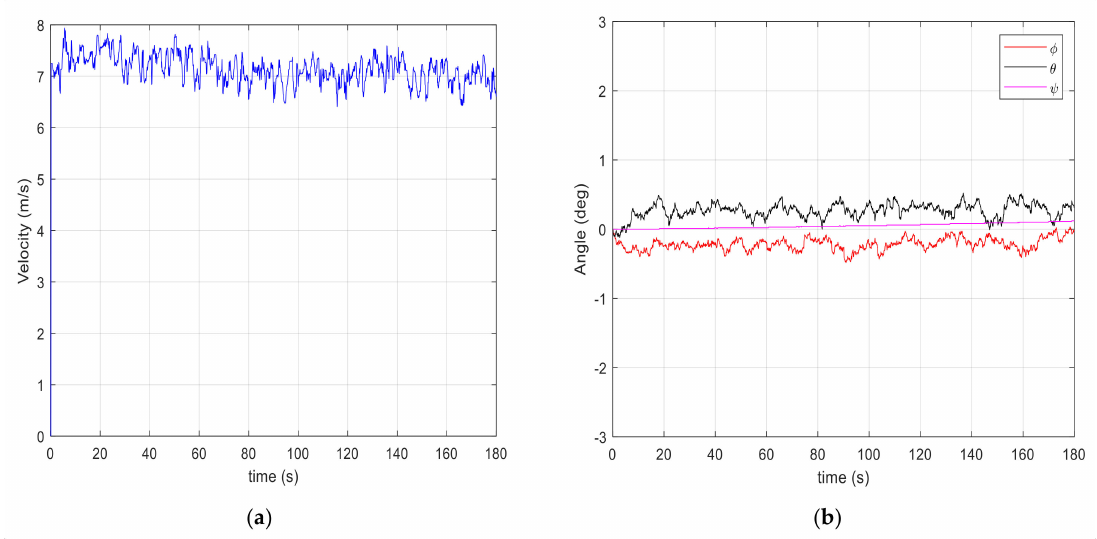
Figure 14. ( a ) The filtered velocity measured by the differential pressure sensor in test case 1. ( b ) The Euler angles after complementary filtering (fusion of gyroscope and accelerometer data from the